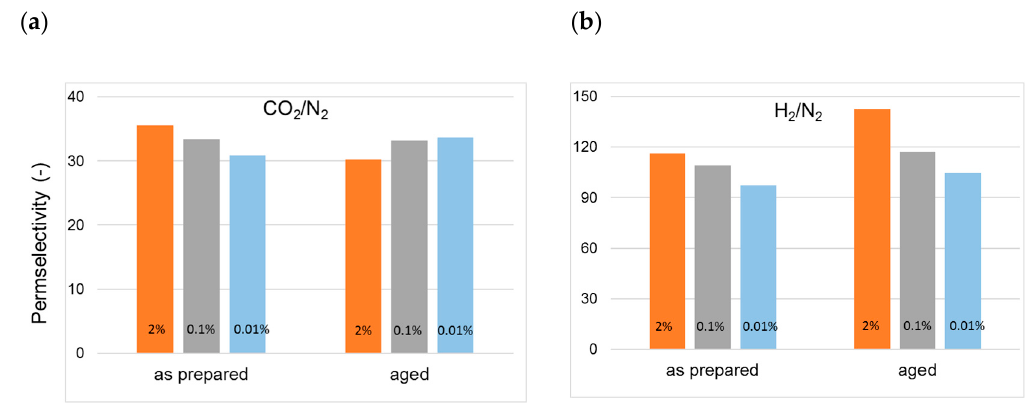
Figure 8. Change in permselectivity over time in cross-linked HF membranes (T3-type) prepared with different EDA concentrations in the bore fluid: ( a ) CO 2 /N 2 ; ( b ) H 2 /N 2 .